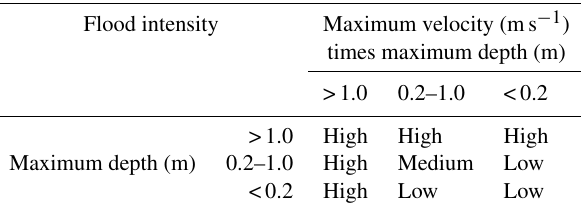
Table 2. Flood intensity classification as a function of maximum depth and velocity (Somos-Valenzuela et al.,